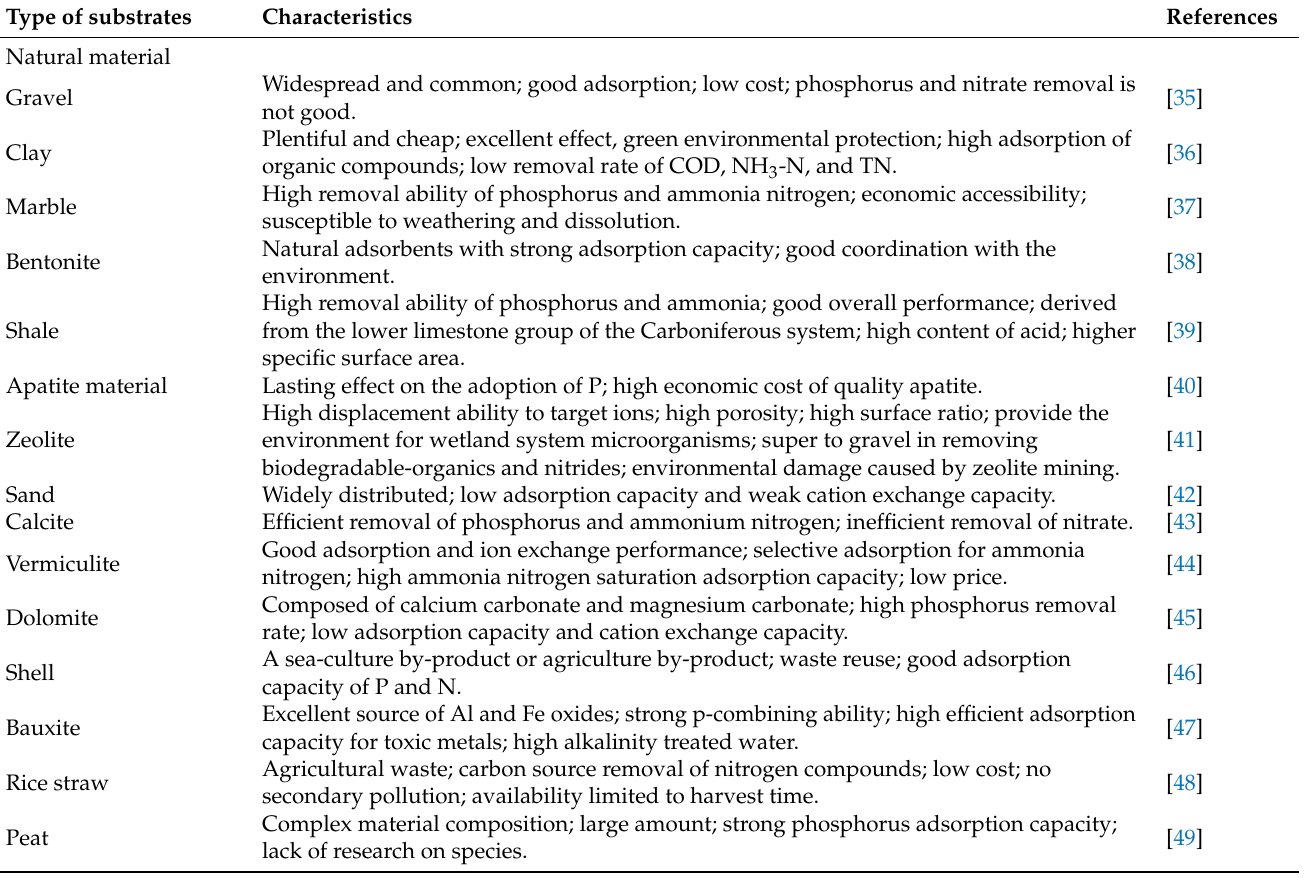
Table 1. Characteristics of substrates used in the constructed